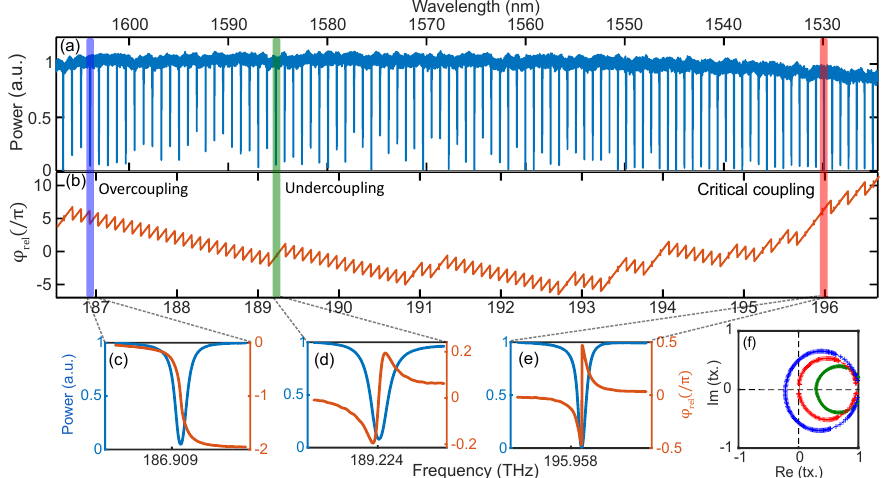
Figure 11. ( a ) Normalized transmission scan of microresonator. ( b ) Linearized effective phase response of the resonator. Different coupling conditions: ( c ) Overcoupling. ( d ) Undercoupling. ( e ) Critical coupling. ( f ) Resonances in the complex plane. The color of the plots corresponds to the resonances marked by the same color bars